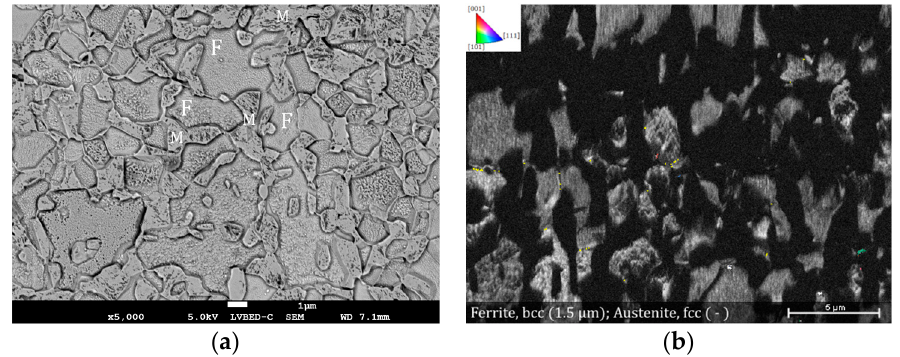
Figure 7. ( a ) Back-scatter electron detector micrograph of Steel D IBT 480 with annotations of phases: F = ferrite, M = martensite. ( b ) EBSD PQM of austenite (fcc) in IPF X colouring phase map and ferrite grain size measurement of the same location of Steel D 480 microstructure.